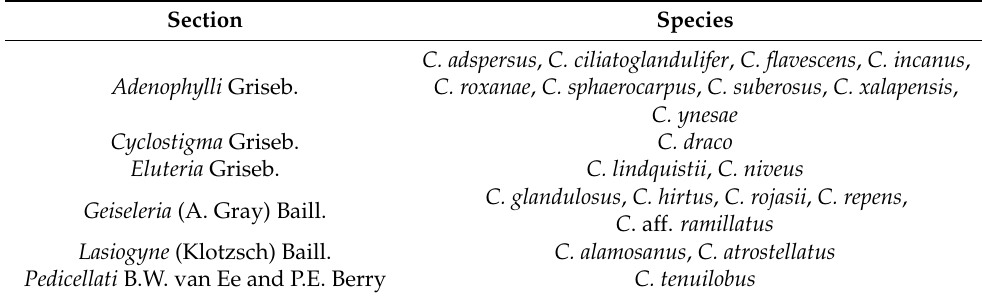
Table 1. Sections and species of Croton present in Michoac á n.